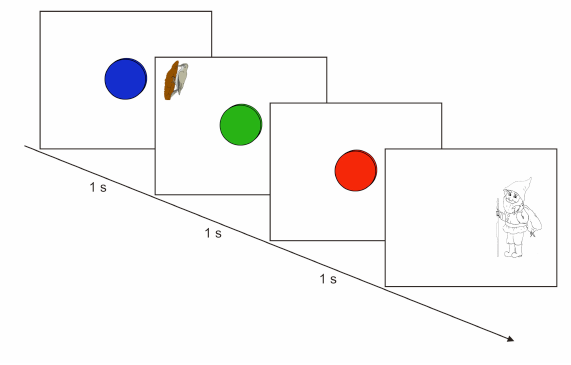
Figure 2 : Sequence of a trial of the Backward Color Recall Task in the condition with distracting stimuli appearing on the array